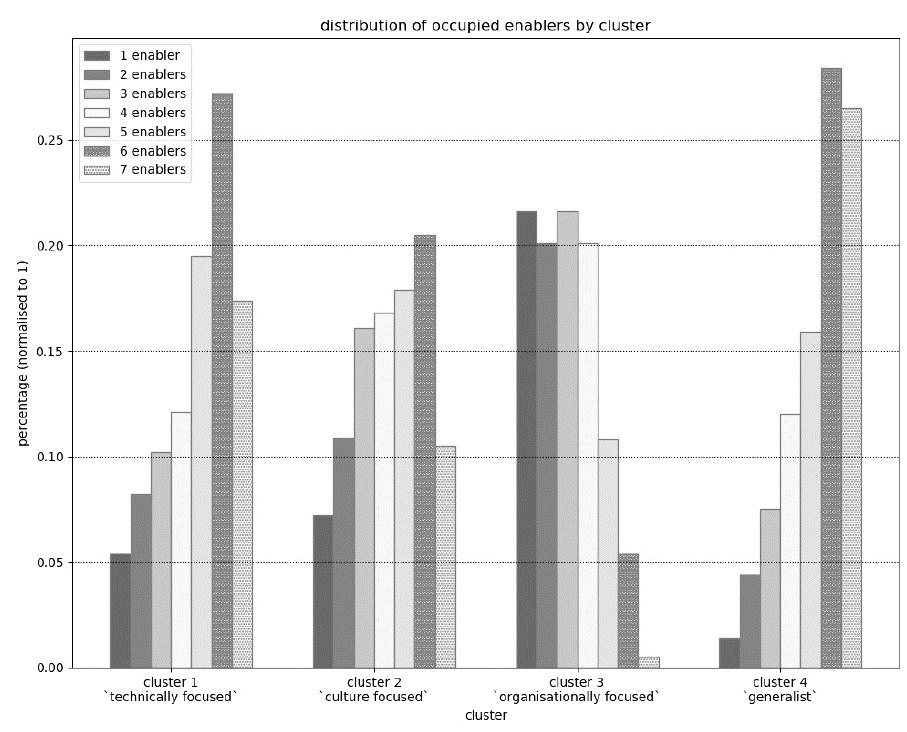
Figure 11. Distribution of occupied bins (enabler) by